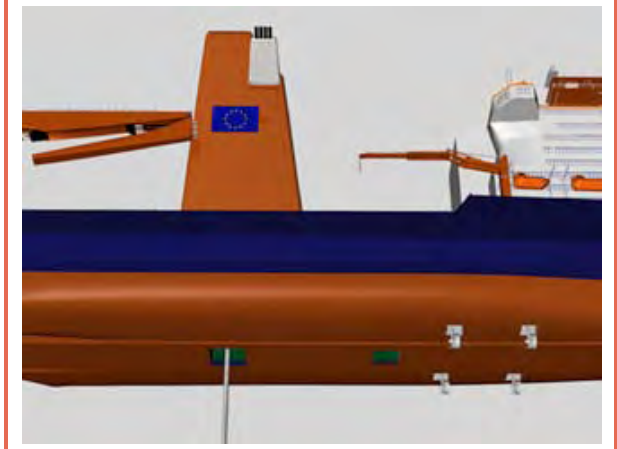
Figure 2. Aurora Borealis will have two moon pools for drilling and the deployment of ROVs or similar